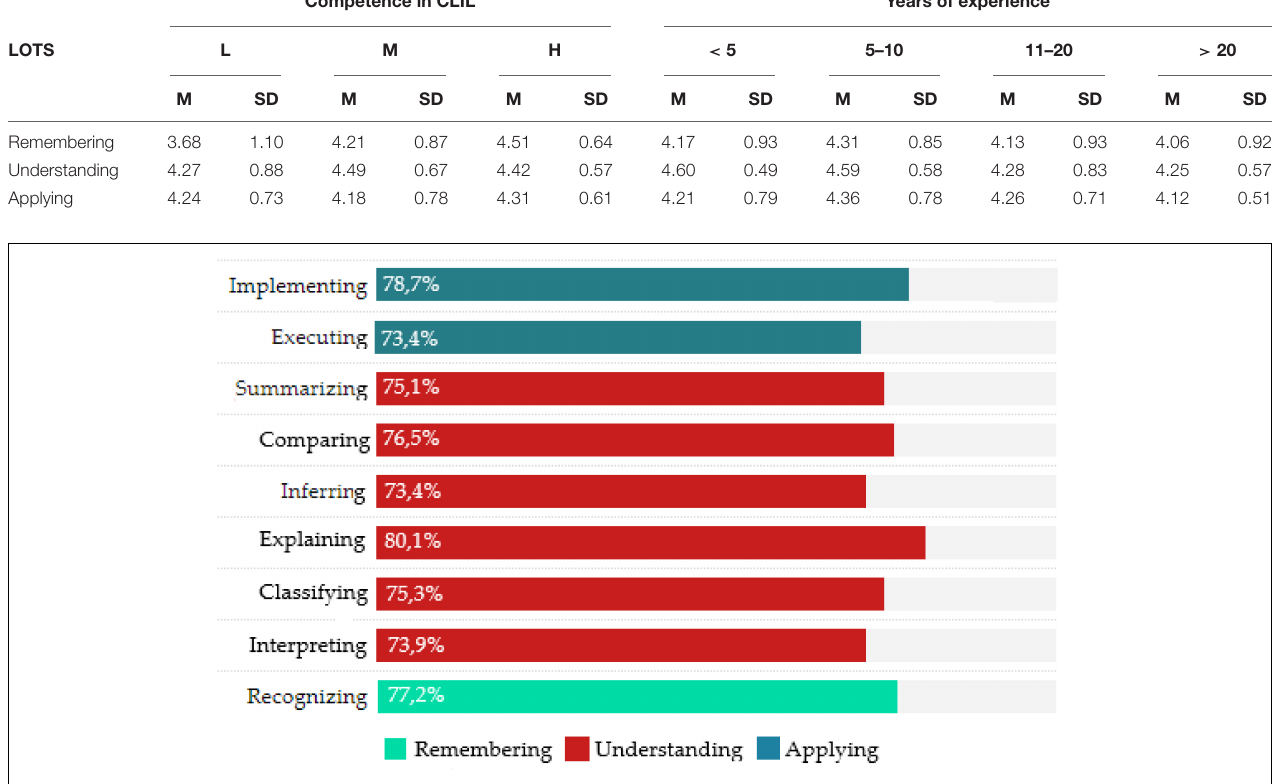
TABLE 2 | Low-order cognitive skills (LOTS) development according to teachers’ content and language integrated learning (CLIL) training and years of experience. Competence in CLIL